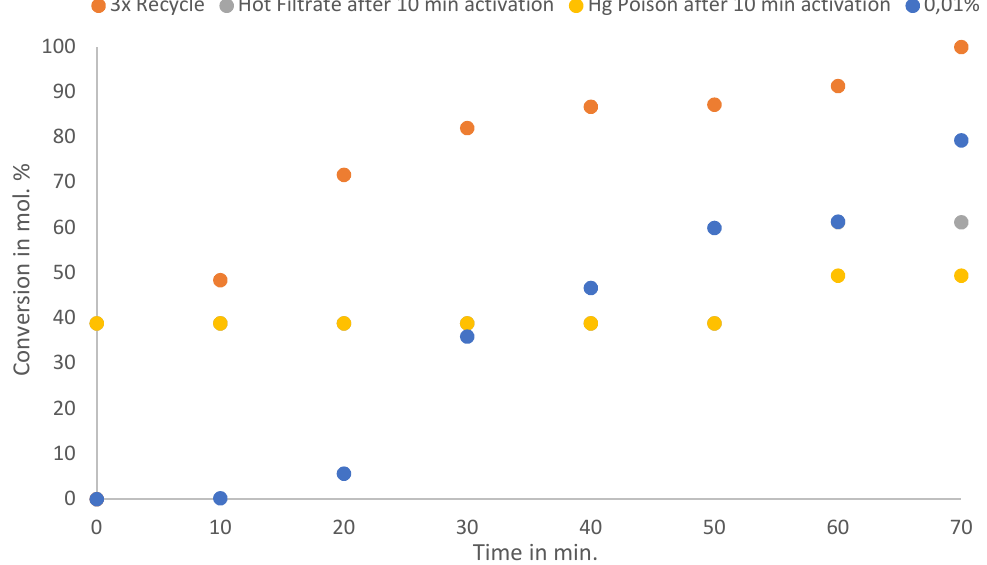
Figure 7. Reaction profile at 10-min intervals of the 3-times recycled catalyst, 0.01 mol% catalyst, and hot reaction filtrate and Hg0-poisoned reaction filtrate.